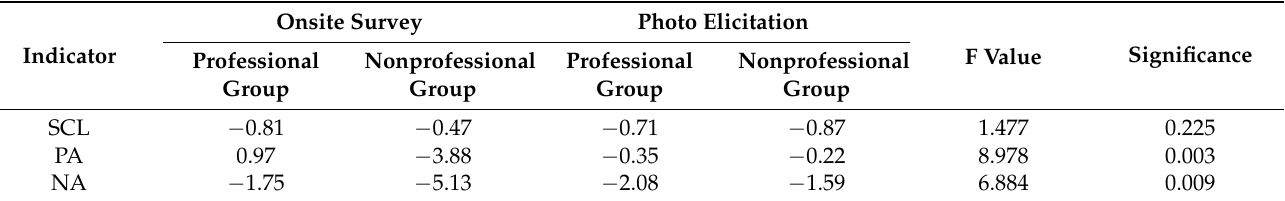
Table 3. Effects of professional background and perception method.